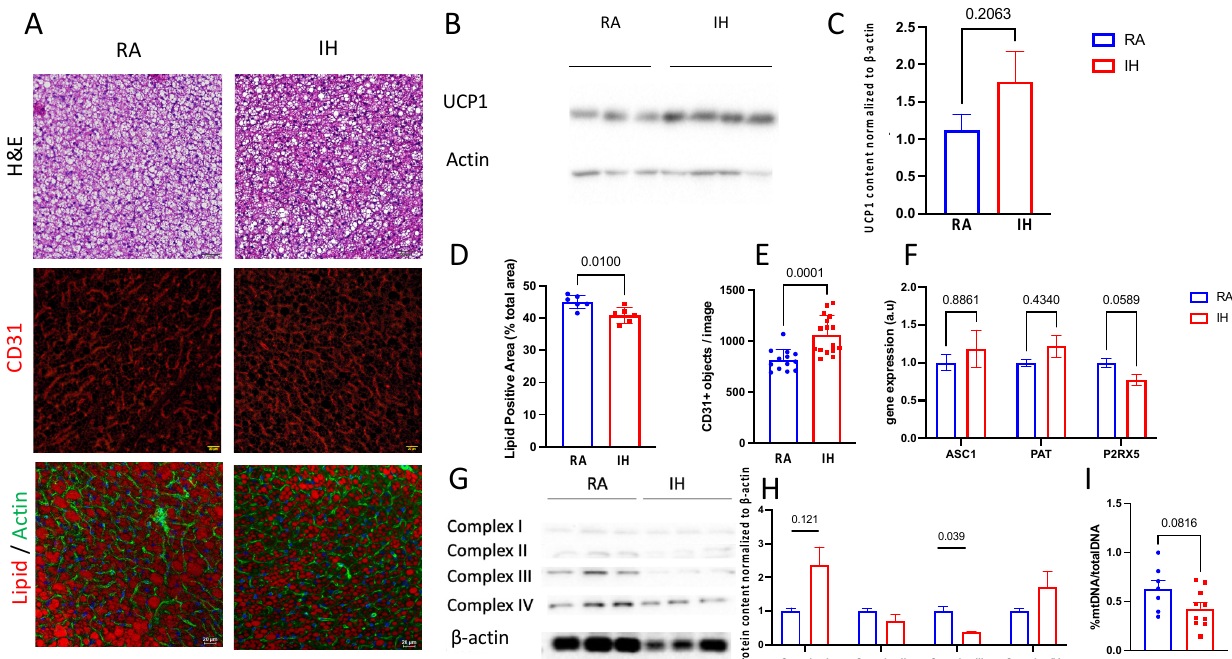
Figure 2. Chronic intermittent hypoxia induces systemic glucose intolerance. Fasting glucose tolerance test following 6-week exposure. ( A ) Fasting glucose levels. ( B ) Glucose curve normalized to baseline glucose levels and the corresponding. ( C ) Area under the curve (AUC) ( n = 17–20). Data presented as means ± SEM. Pairwise comparisons were performed using Student’s t -test. AUC was calculated using the trapezoidal method.